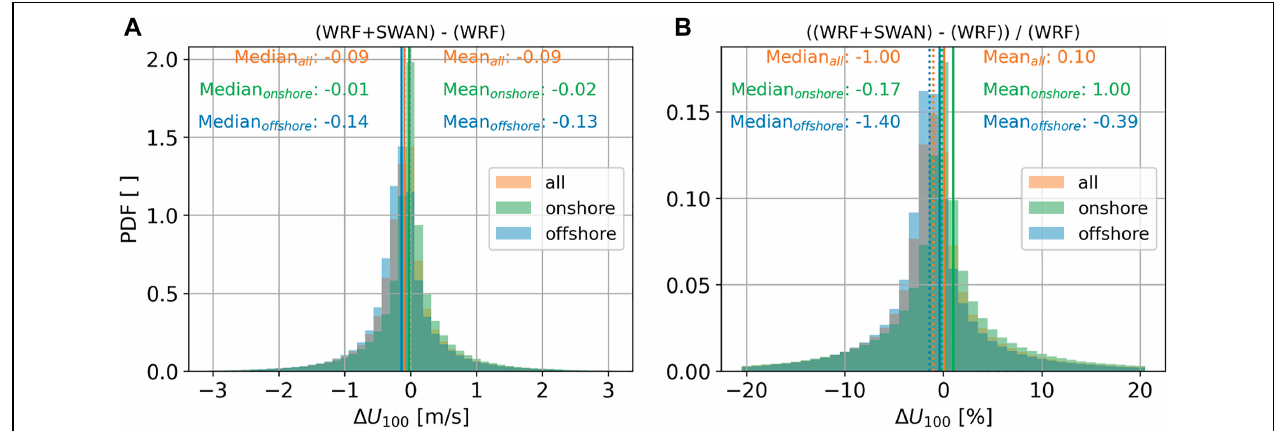
FIGURE 12 | Histogram of simulated relative U -difference at 100 m height for (A) the absolute difference (WRF + SWAN)-(WRF) and (B) the relative difference ((WRF + SWAN)-(WRF))/(WRF) over the entire analysed area shown in Figure 9 (orange) and for the respective offshore and onshore areas only (blue and green, respectively). Solid lines show mean differences and dotted lines median difference.